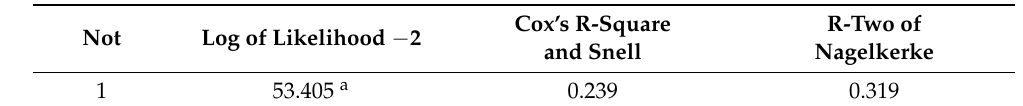
Table A7. Table of Models summary.